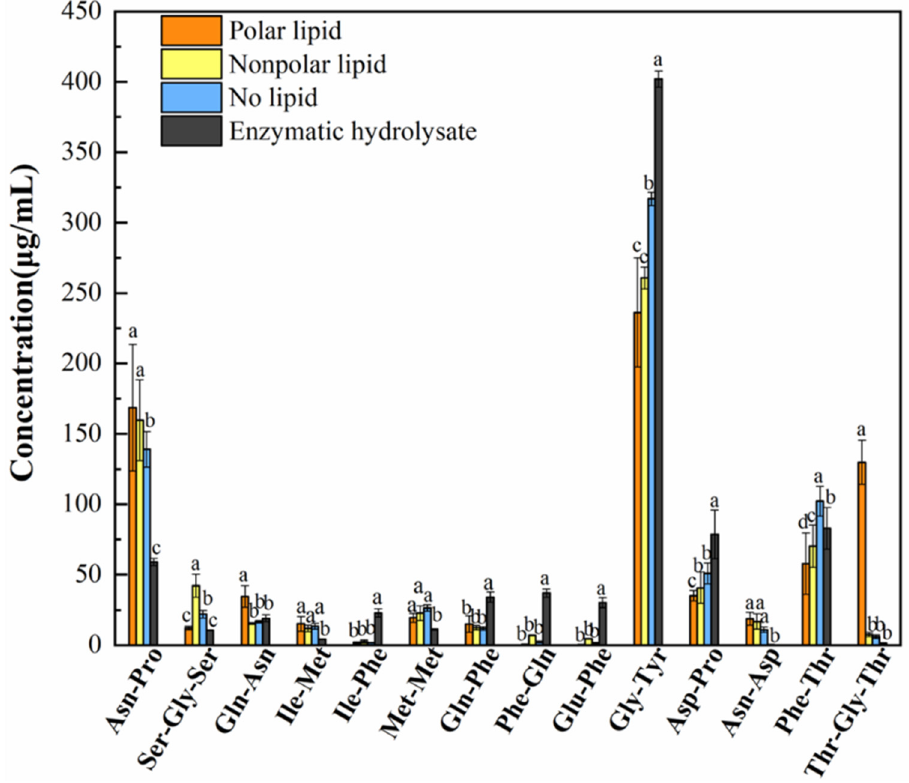
Figure 6. Oligopeptides with obvious changes in MRPs added with different polar lipids.